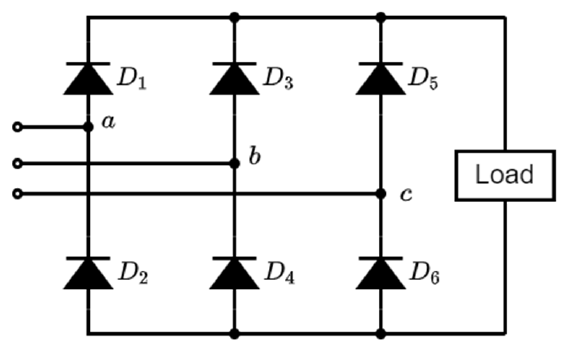
Figure 11. Three-phase full-bridge rectifier.